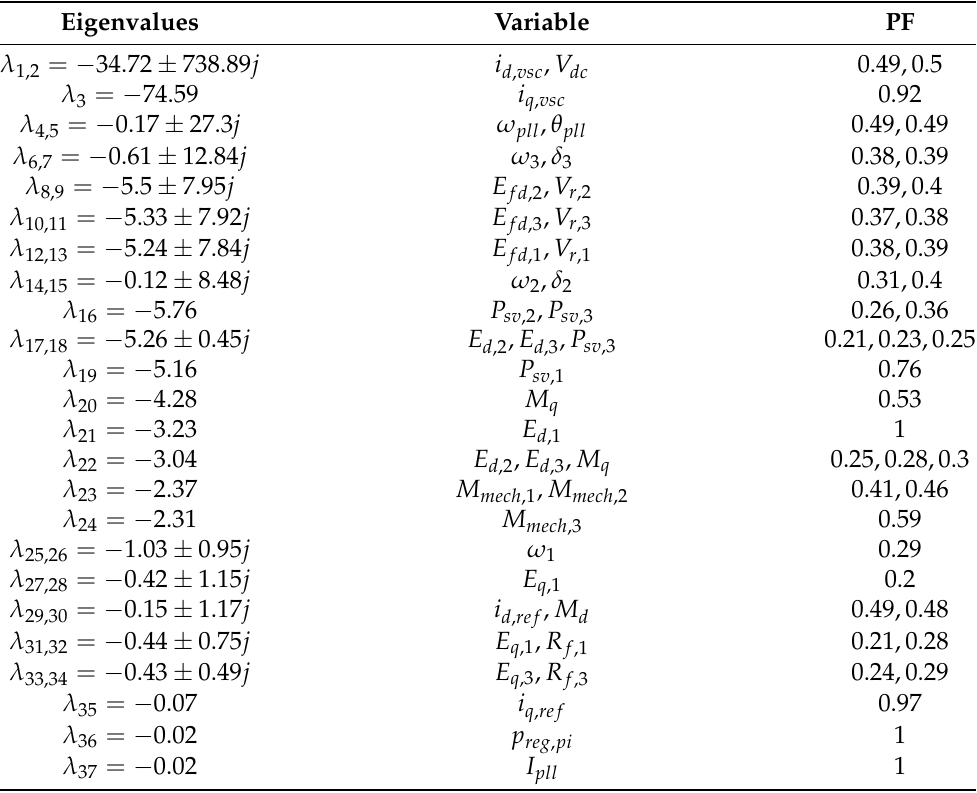
Table 2. The eigenvalues and participation factors of the system with vector control.